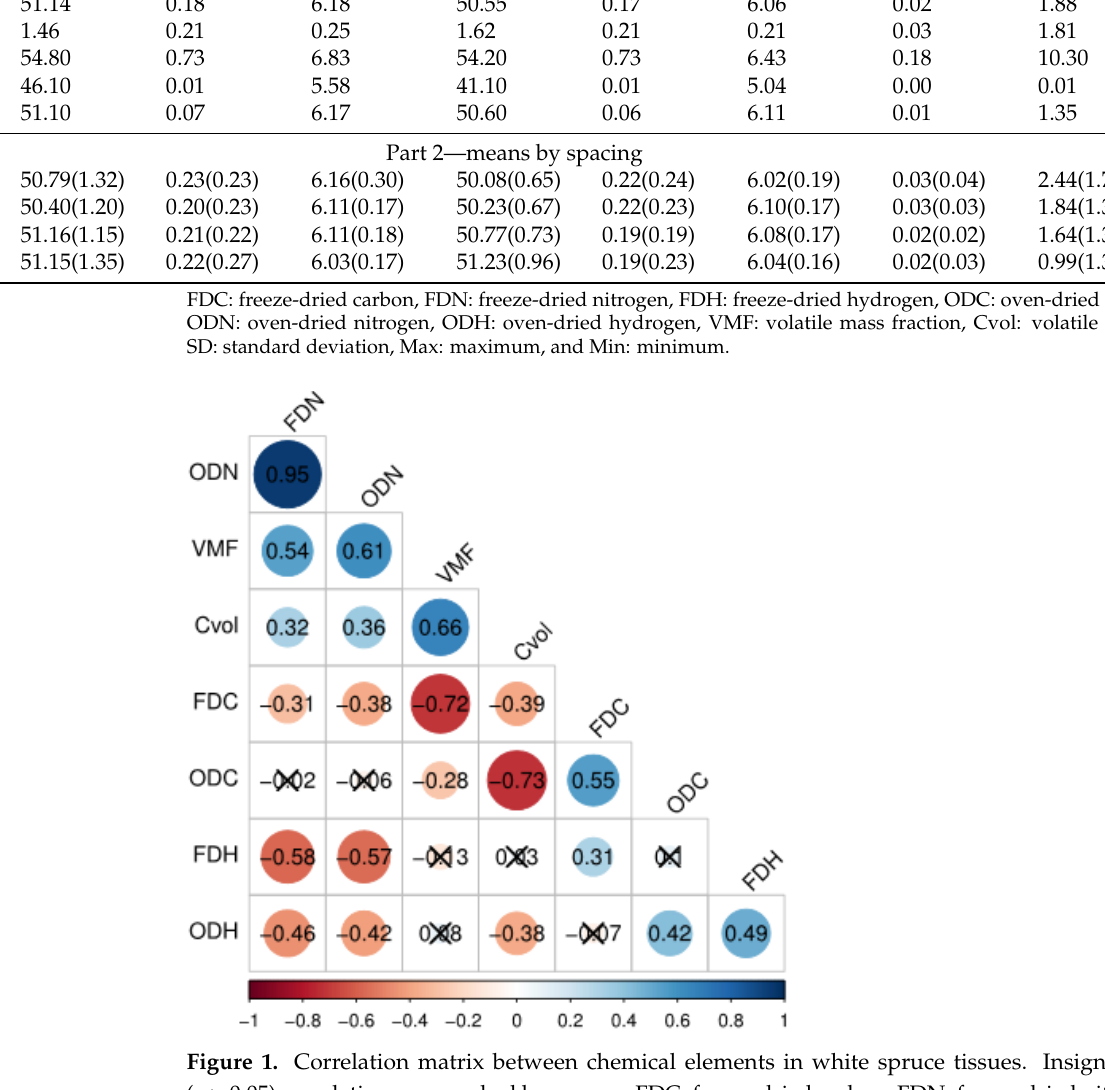
Table 1. Summary of chemical characteristics of spaced spruce trees.